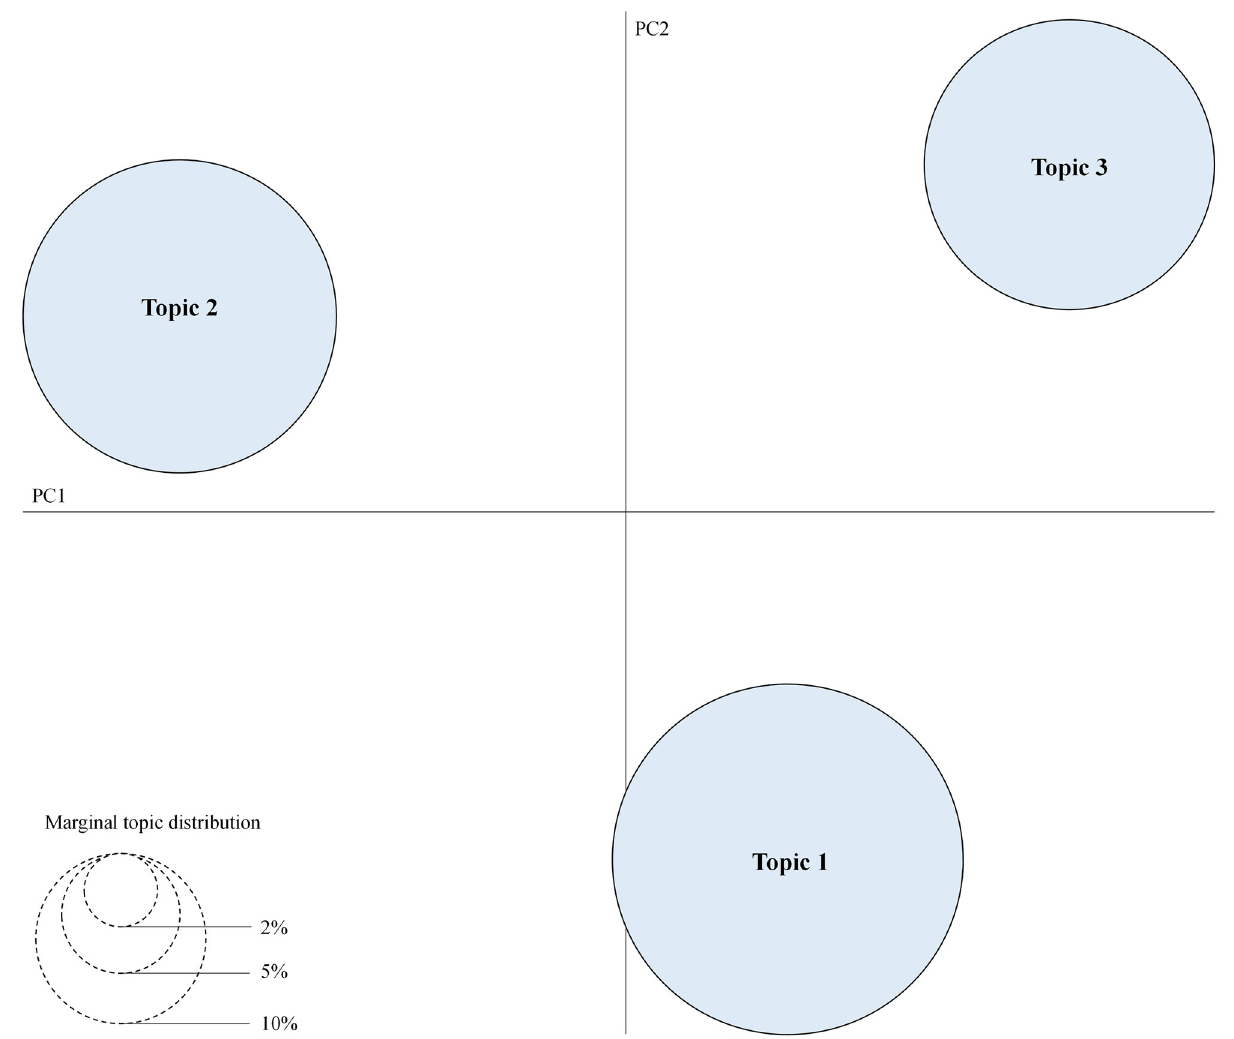
Fig 11. IDM of the three clusters categorized using the LDA model.